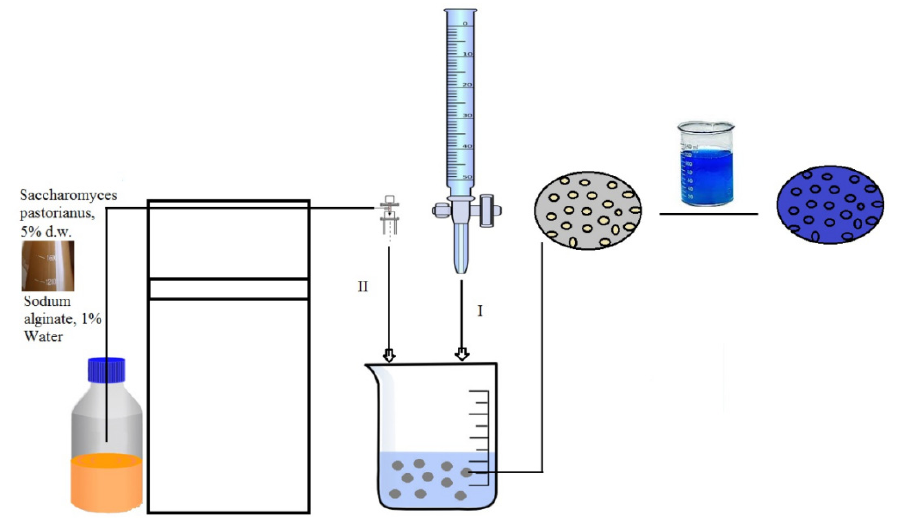
Figure 1. Systematization of procedures for obtaining biosorbents based on residual microbial biomass immobilized in sodium alginate matrix: (I) a simple dripping technique; (II) encapsulated using a Buchi microencapsulator.